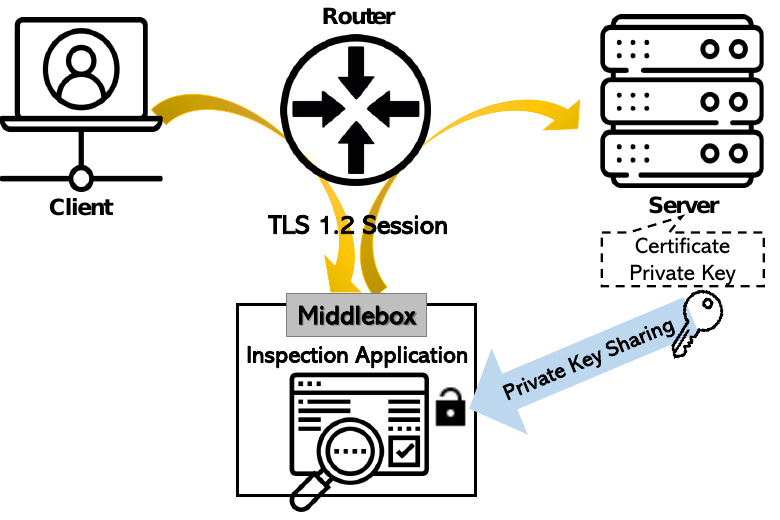
Figure 2. TLS inspection with a private